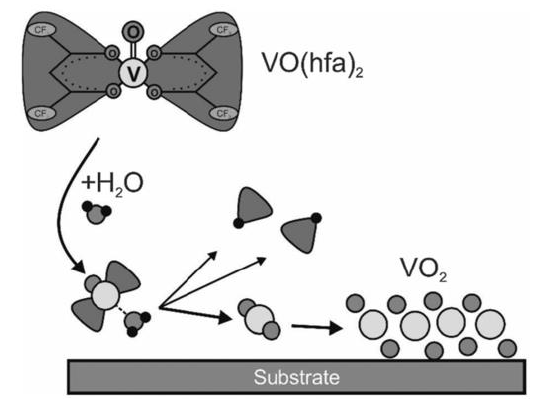
Fig. 1. The scheme of reaction between VO(hfa) 2 molecule and water resulted to formation of VO 2 .